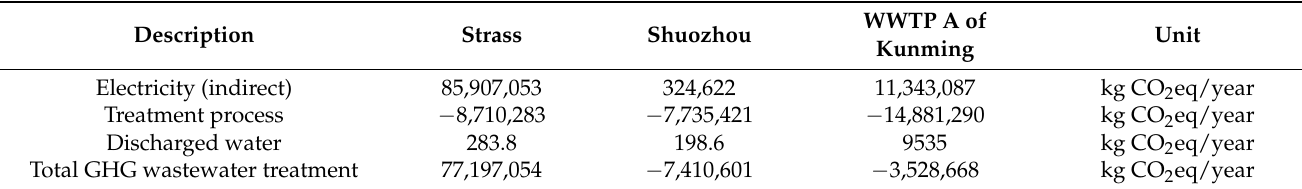
Table 7. Detailed greenhouse gas assessment data of ECAM in wastewater treatment stage of Strass, Shuozhou and WWTP A of